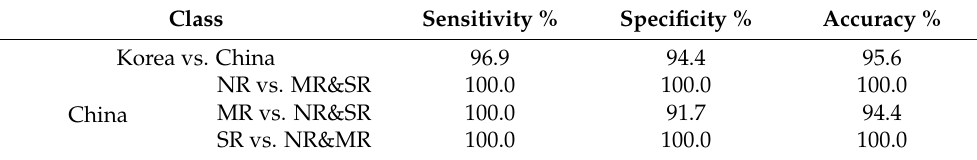
Figure 1. OPLS-DA score plots ( A ) derived from the 1 H-NMR spectra of soybean samples for discriminating geographical origin, Korea and China. Leave-one-out cross-validated score plots ( B ) showing Korean soybeans (above dashed line) and Chinese soybeans (below dashed line) with threshold value of 0.5 (dashed line) for all samples. In case of misclassified samples, the Ypredcv values were marked with red circles. Table 3. Classification performance parameters (sensitivity, specificity and accuracy) of OPLS-DA model to discriminate between Korean and Chinese soybeans, and partial least squares-discriminant analysis (PLS-DA) models for discriminating between three regions for Chinese soybeans using leave-one-out cross-validation.